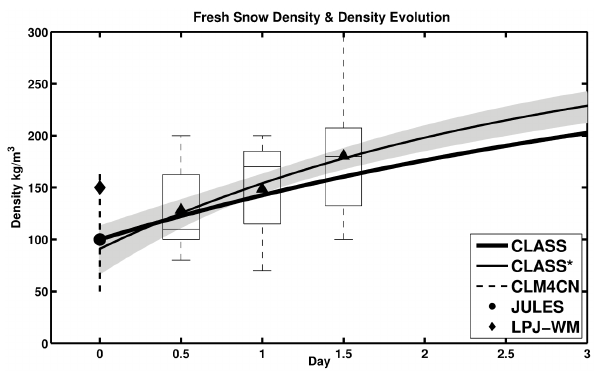
Figure 3: Fresh snow density (day=0) in CLM4CN, JULES and LPJ-WM as well as snow density evolution in the CLASS model. Box plots show snow density statistics extracted from the transect data with the triangle showing the mean value. CLASS* shows the snow density evolution in the CLASS model but with parameters obtained through regression analysis; the gray area depicts 80% confidence intervals.